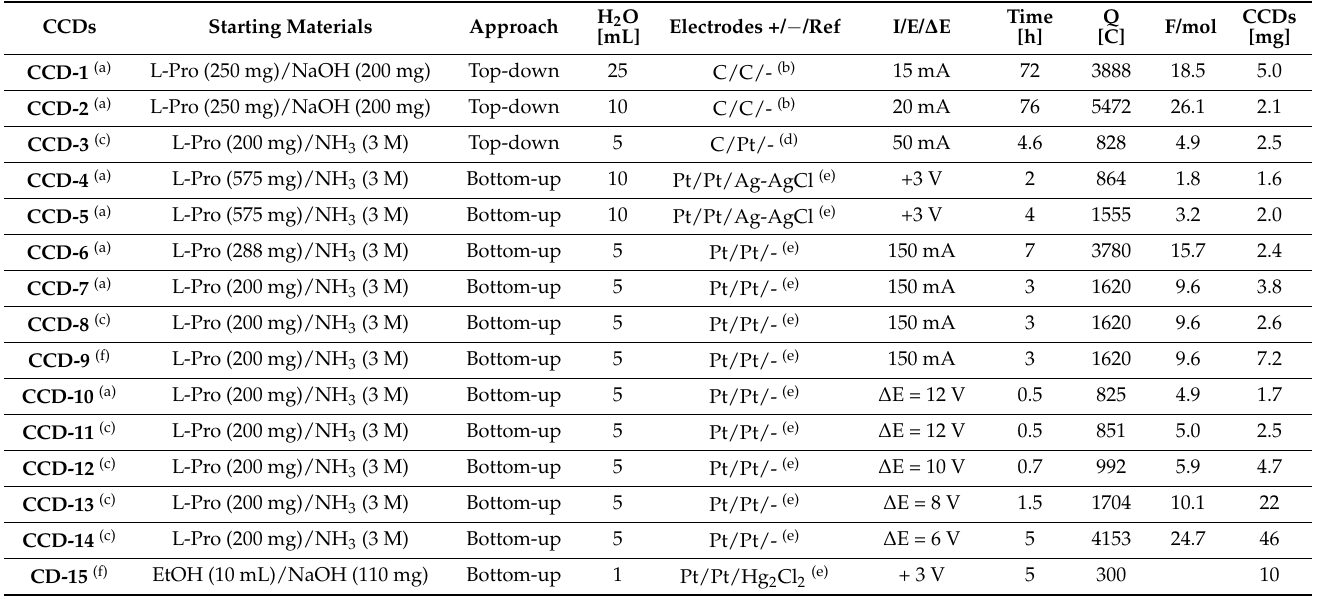
Table 1. Reaction conditions screening for the electrochemical synthesis of CCDs from